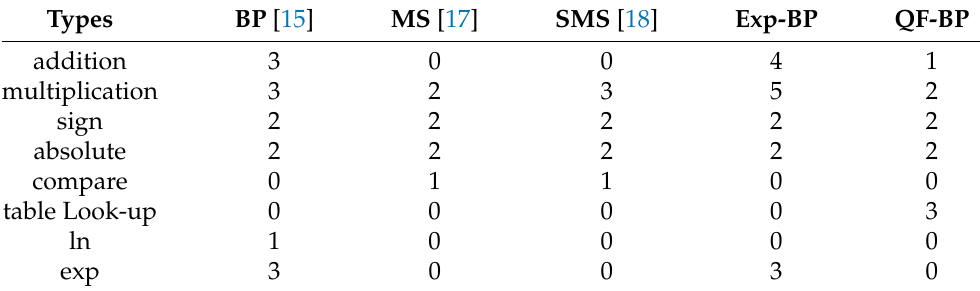
Table 4. The number of operation types contained in the updating formula of different algorithms.